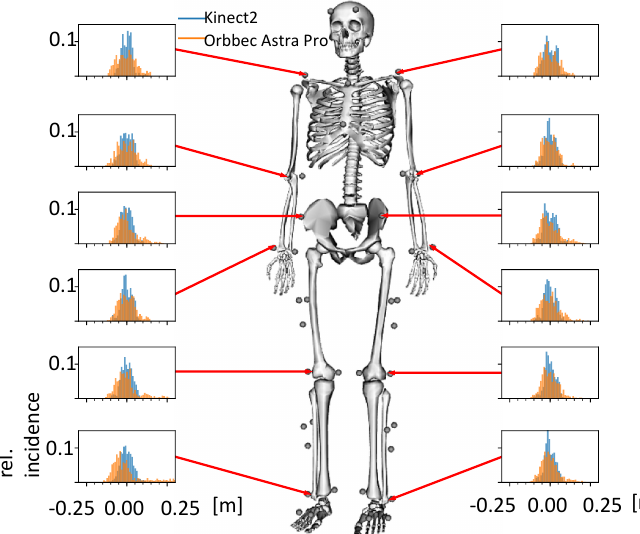
Figure 3. Histograms of the errors between the Kinect2 (blue) and Orbbec Astra Pro (orange) compared to a Vicon system for different joints.